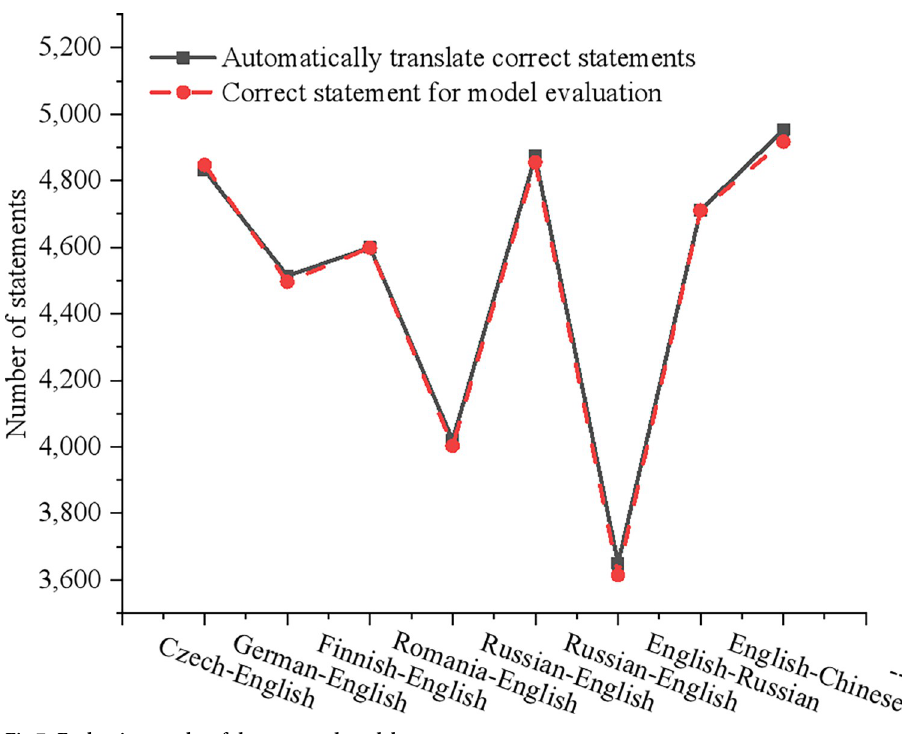
Fig 7. Evaluation results of the proposed model.